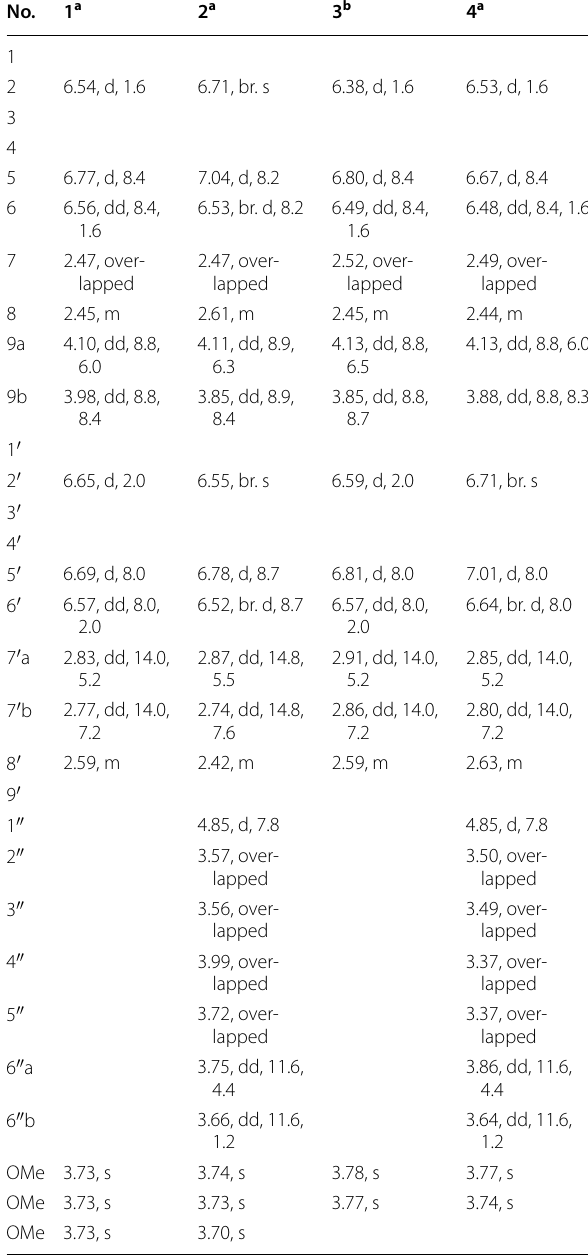
Table 1 1 H-NMR (400 MHz) data of